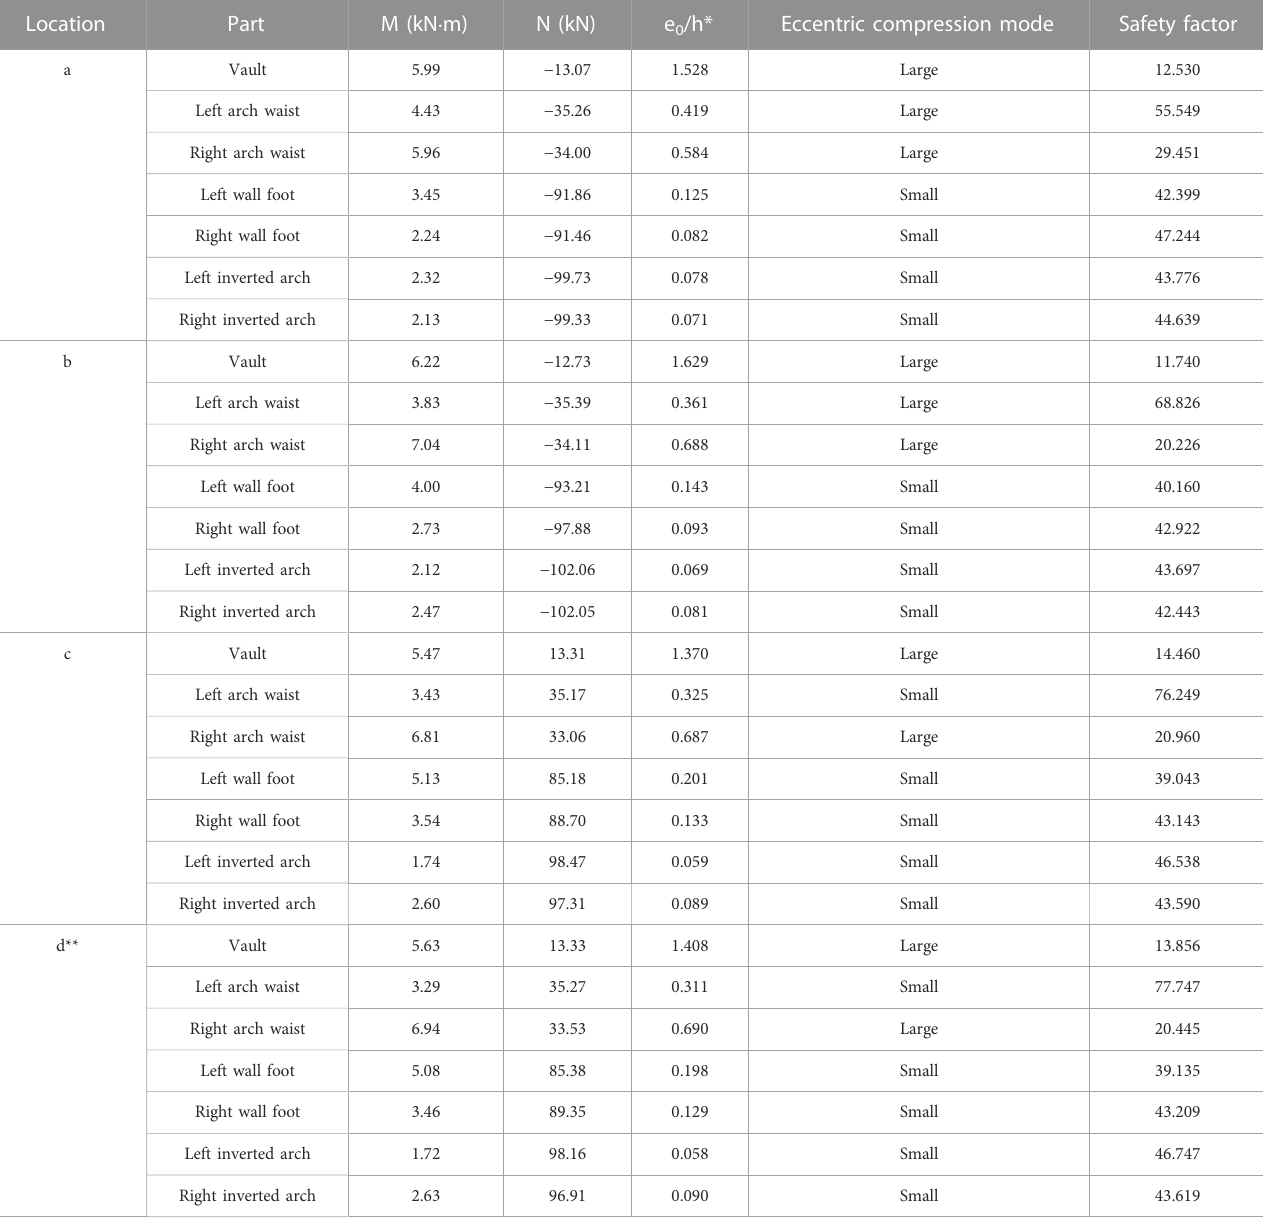
TABLE 8 Summary of structural stress of Section 2